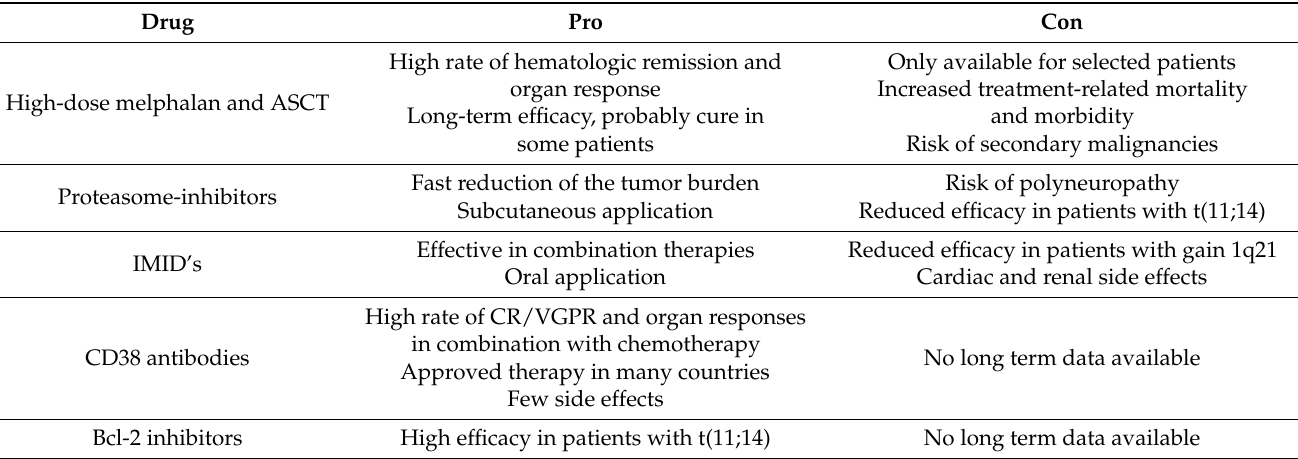
Table 3. Pro’s and con’s of main